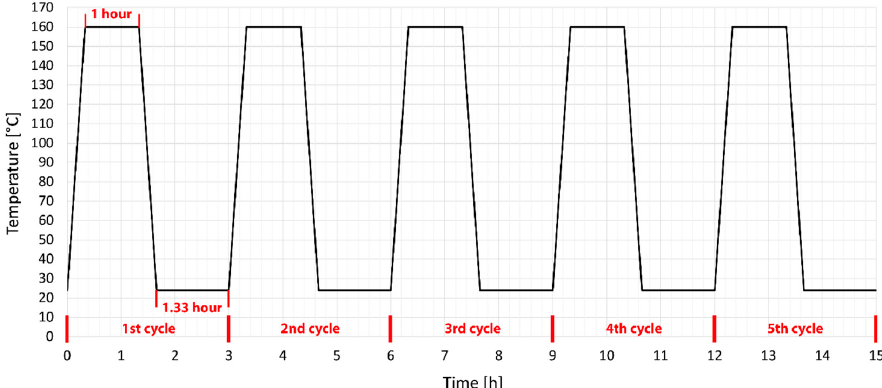
Figure 3. Setting temperature ageing cycle of HDPE above the melting point.